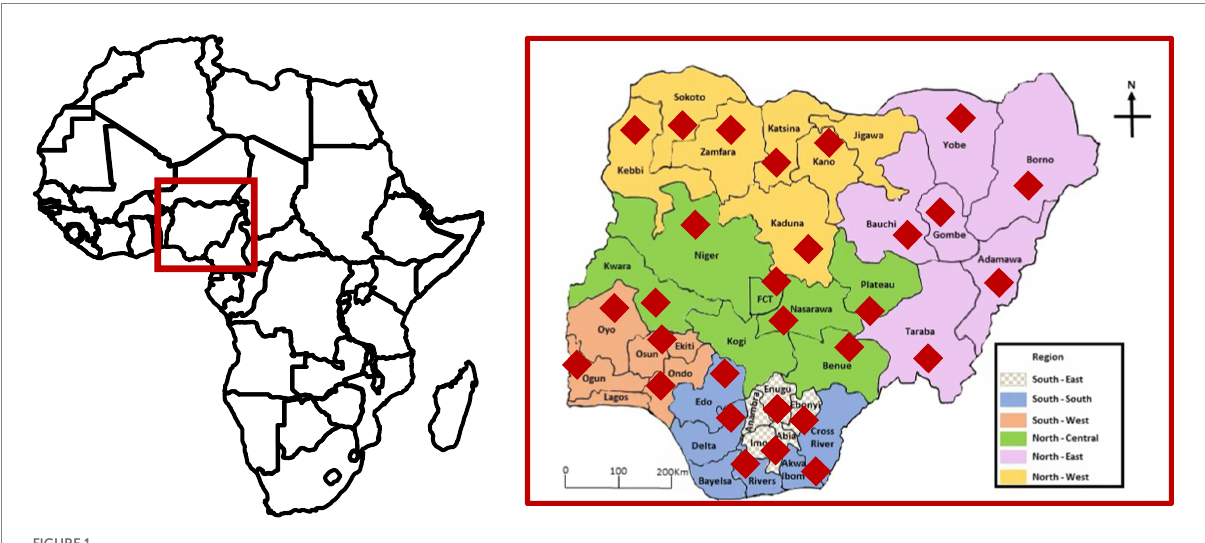
FIGURE 1 Map of Africa (left) showing the location of Nigeria and map of Nigeria (right) showing its six geopolitical zones. The biocontrol product was used in several states in each zone. The red diamonds show the states where (i) the biocontrol effectiveness trials in maize were established and (ii) where maize from open markets were